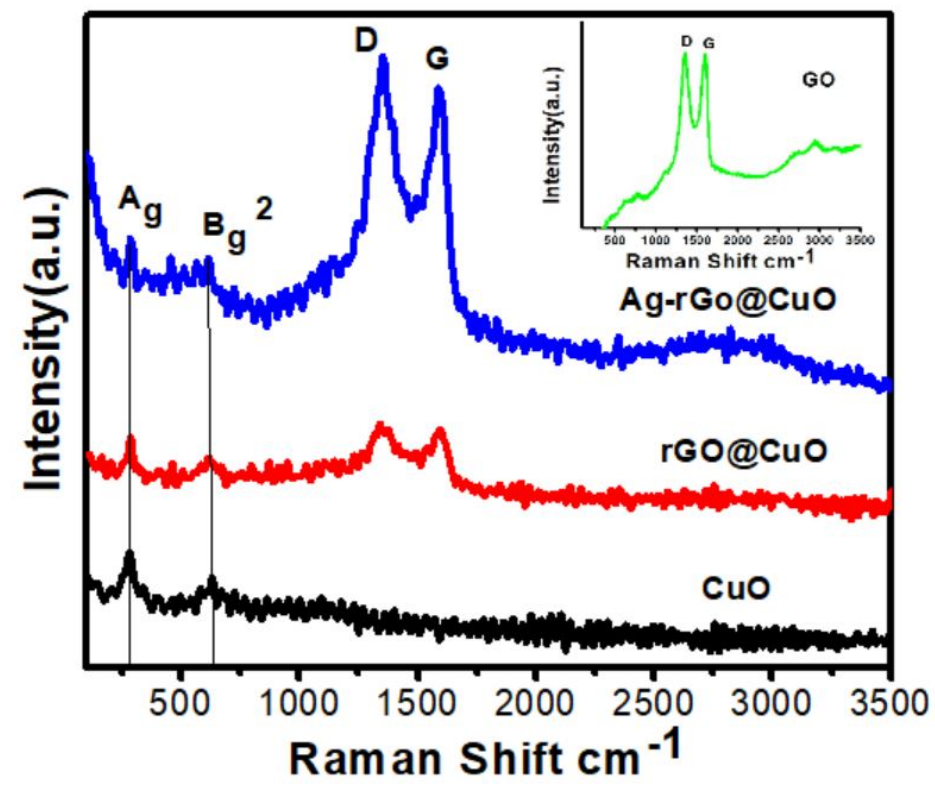
Figure 6. Raman shift of pure CuO nanosheets, rGO@CuO and Ag-rGO@CuO nanocomposites.